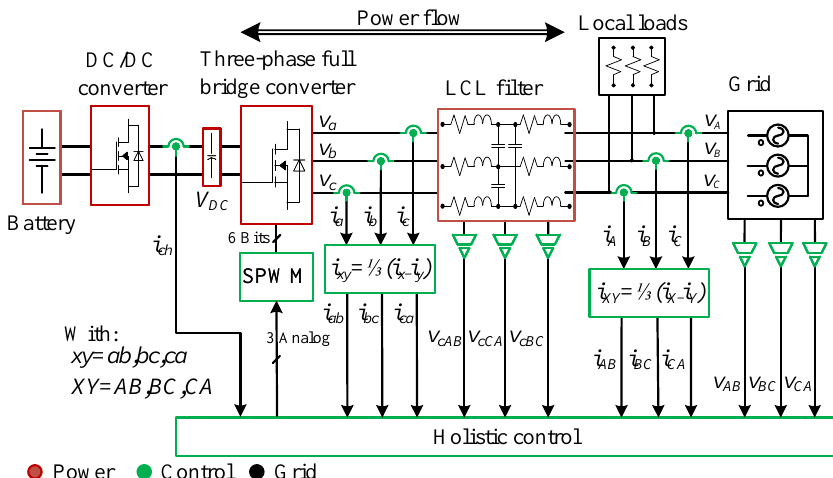
Figure 2. BESS system along with holistic